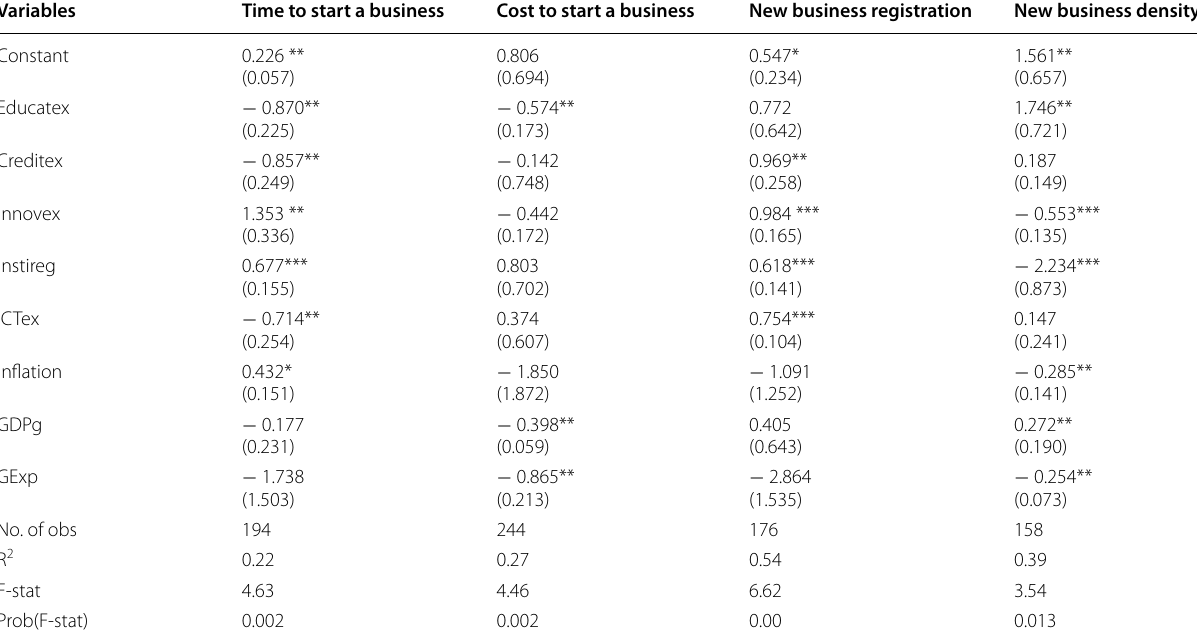
The estimated coefficients are given in the table followed by the standard errors in parenthesis. ***, **, * indicates the level of significance at the 1%, 5%, and 10%, respectively